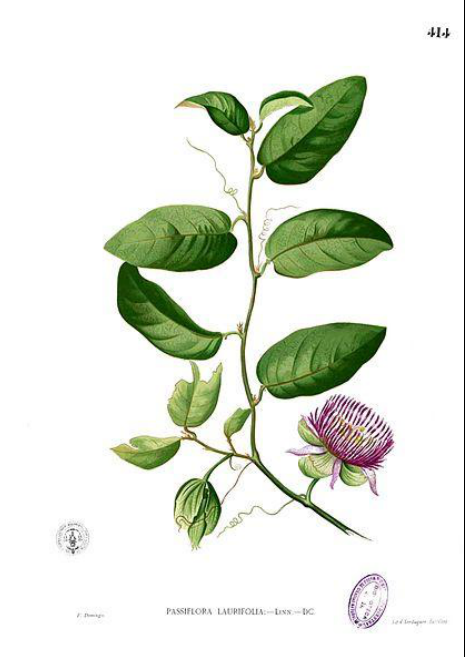
Figure 2. Passiflora laurifolia by Francisco Manuel Blanco (1880–1883). A species in